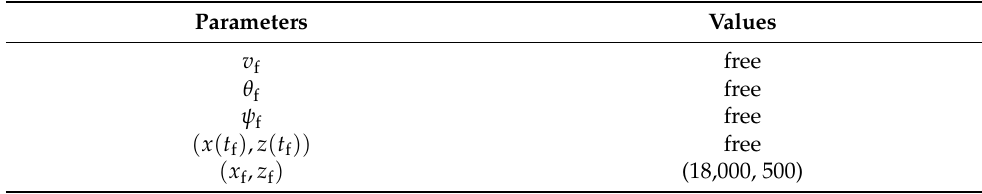
Table 3. Parameters of constraints.